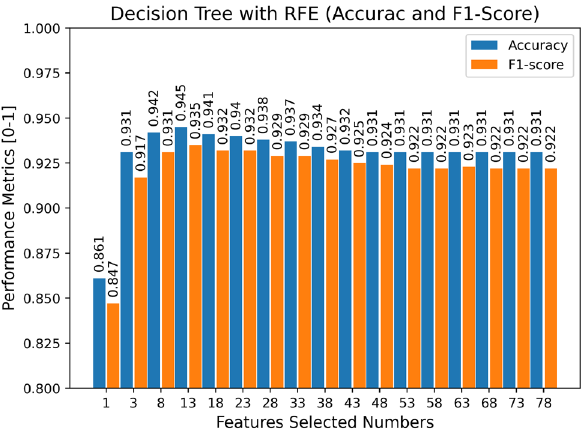
Figure 6. The results of Decision Tree with RFE (Accuracy and F1-Score).